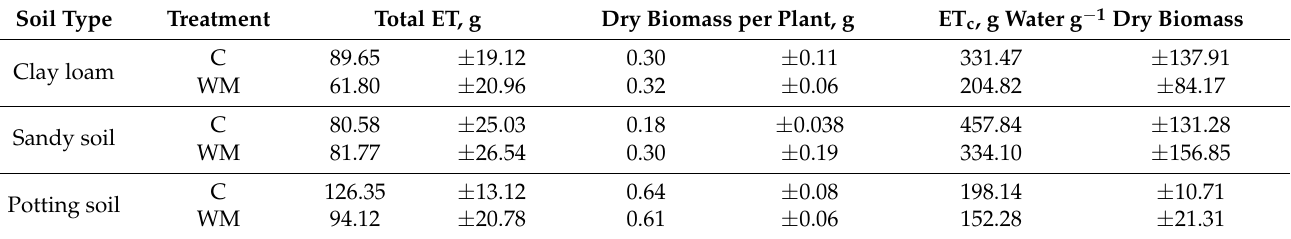
Table 1. The effect of wool mulch on total evapotranspiration (ET), biomass growth, and evapotran- spiration coefficients (ET c ) in different soil types in a short-term pot experiment (mean ± standard deviation).